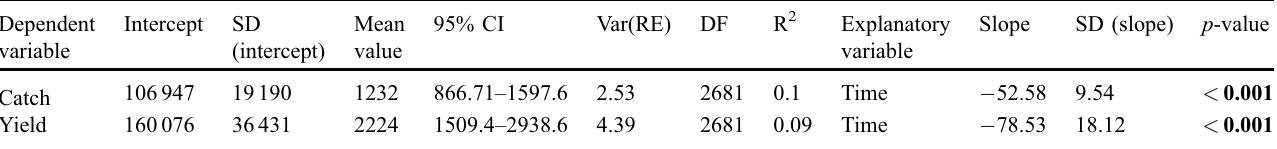
SD =standard deviation; CI= con fi dence interval; var(RE)= variance for random effect; DF = degrees of freedom. Statistically signi fi cant results are in